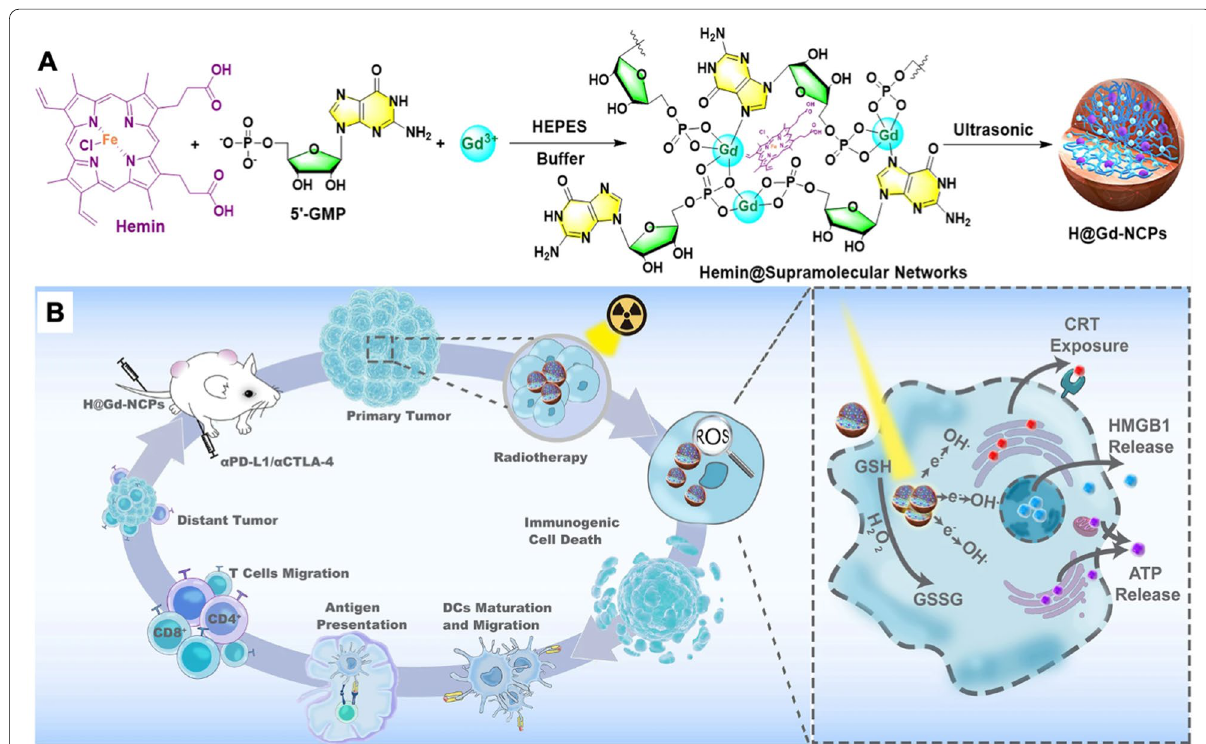
Fig. 9 A Preparation of a novel radiosensitizer that incorporates nanoscale coordination polymers (NCPs) based on gadolinium (Gd 3 + ) and 5 ′ -Guanosine monophosphate (5 ′ -GMP) via supramolecular self-assembly. B Mechanism of radiosensitization via amplification of radiotherapy-mediated oxidative stress. Dendritic cells (DCs), glutathione (GSH), oxidized glutathione (GSSG), hydroxyl radicals (•OH), calreticulin (CRT), high mobility group protein B1 (HMGB1), adenosine triphosphate (ATP). Reprinted with permission, [347] https:// doi. org/ 10. 1038/ s41467- 020-